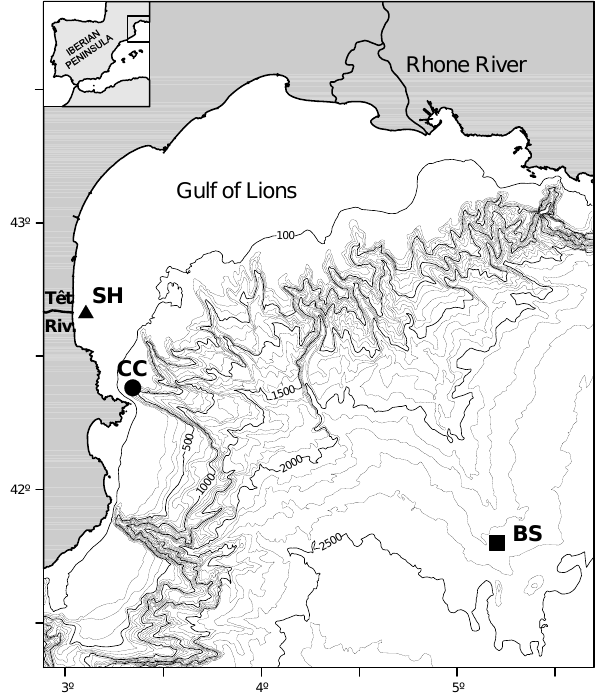
Fig. 1. Bathymetry map of the Gulf of Lions showing the location of the inner shelf (SH) instrumented tripod (triangle), the Cap de Creus (CC) canyon head mooring site (circle) and the basin site (BS) mooring